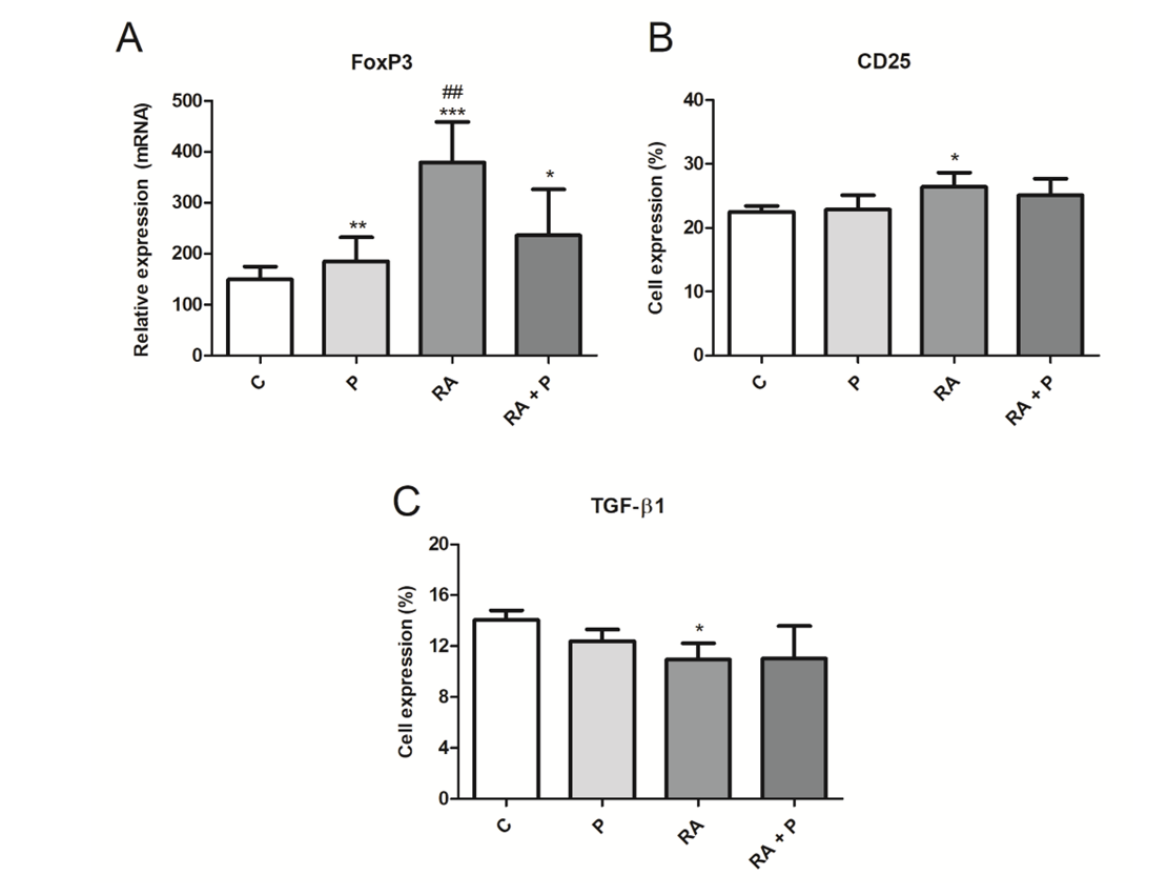
Figure 6. (A) FoxP3 relative expression and percentage (%) of lymphocytes expressing (B) CD25 and (C) TGF-β1 after 120 h of co-culture with autologous dendritic cells treated with RPMI 1640 (control – C), retinoic acid (A – 10 -7 M), propolis (P – 5 μg/mL) or their combination. Data represent mean and standard deviation (n = 5). Significantly different from control: *( p < 0.05), **( p < 0.01), ***( p < 0.001). Significantly different from RA + P: ## ( p < 0.01).